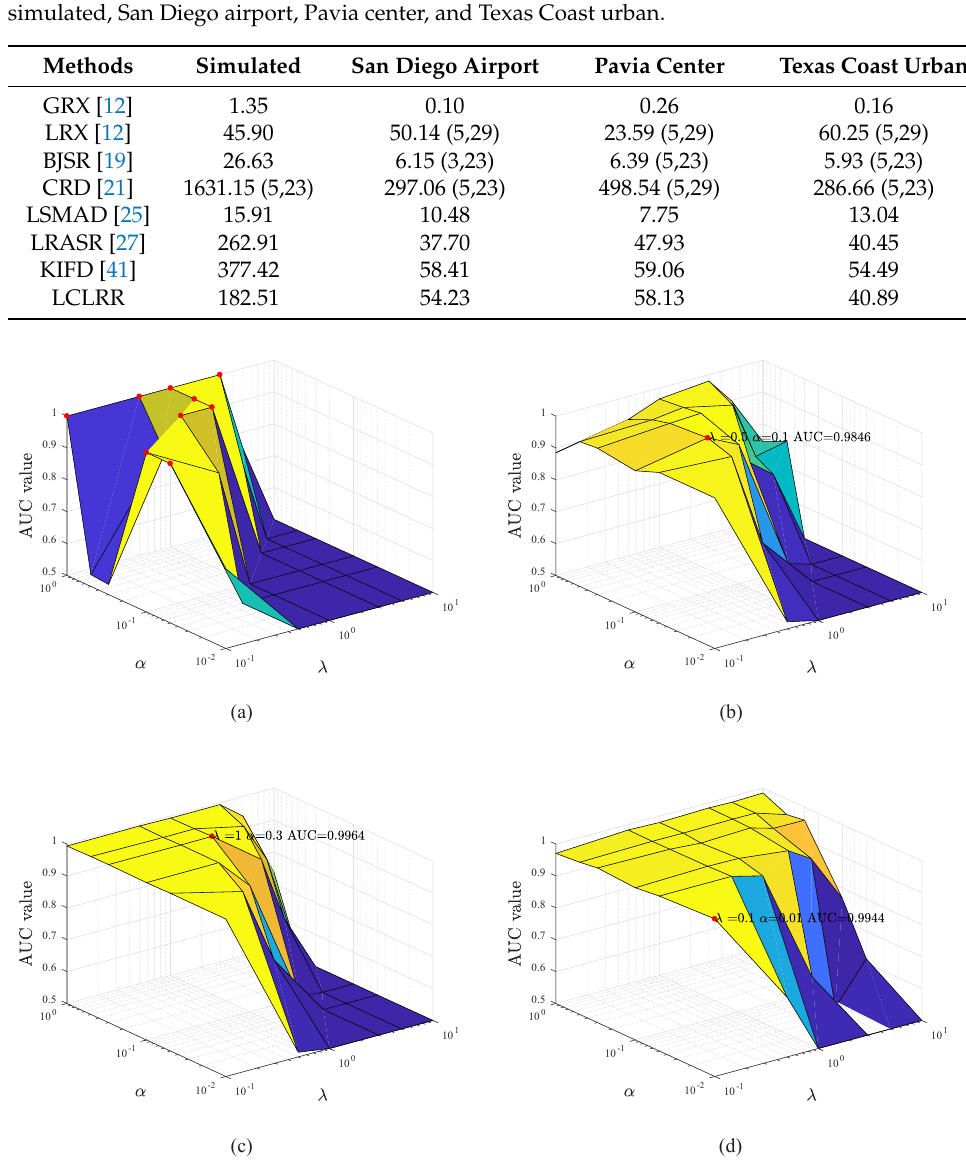
Figure 11. The influence of parameter λ and α on the detection performance for four datasets. ( a ) Simulated. ( b ) San Diego airport. ( c ) Pavia center. ( d ) Texas Coast